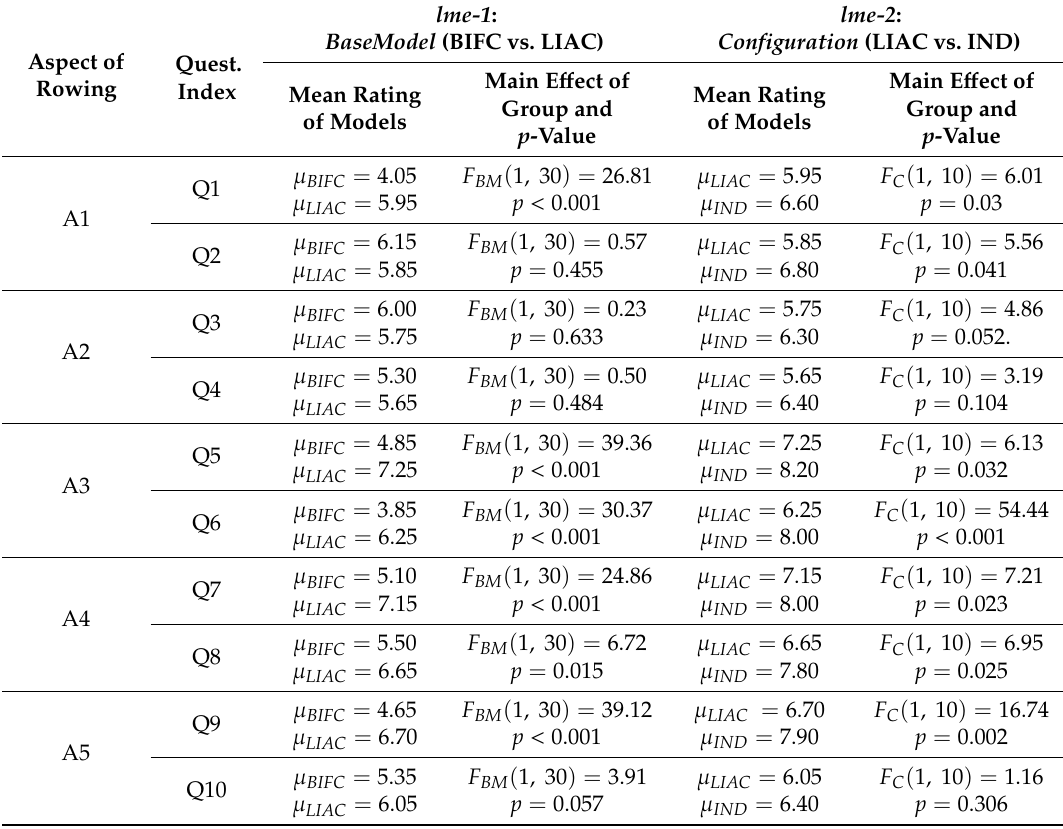
Table 2. Statistical results from lme-1 and lme-2 models for each question in the